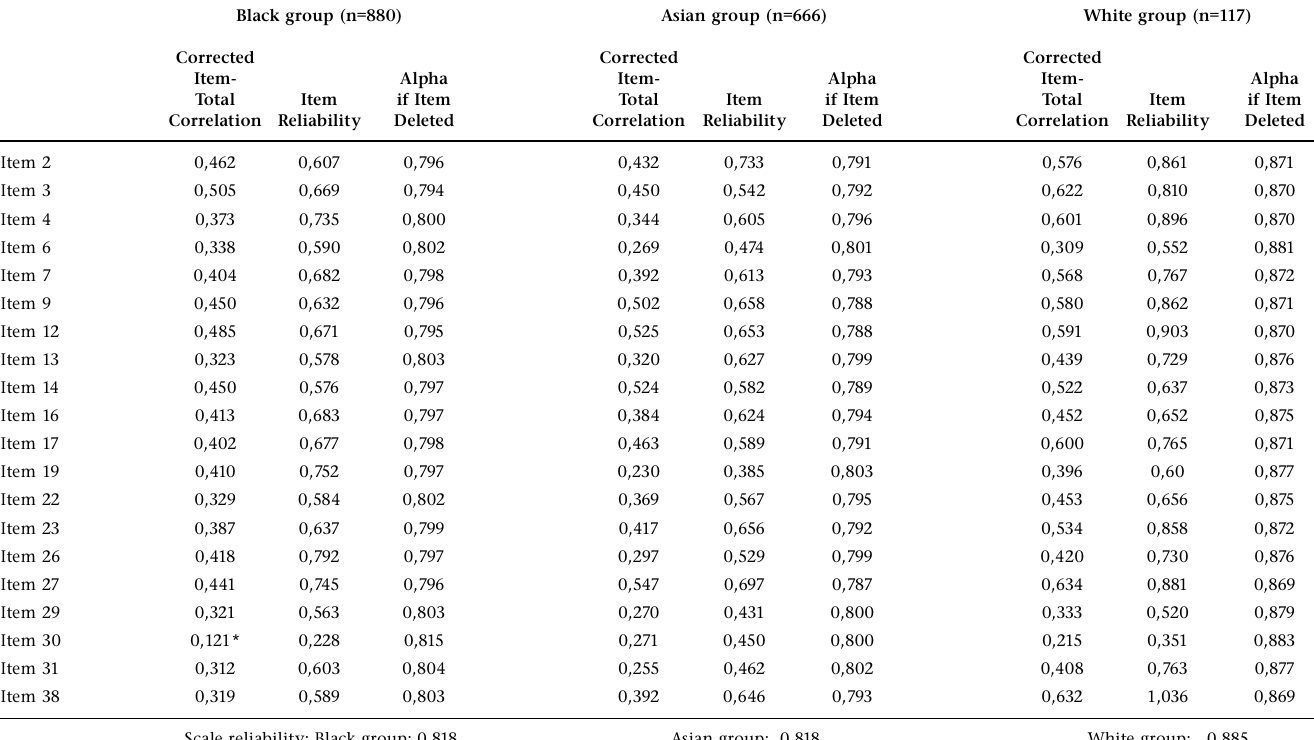
The factor analyses resulted in the extraction of a total of 14 factors for the Black, Asian and White groups. With reference to Figure 1 (Black group), Figure 2 (Asian group) and Figure 3 (White group), two significant factors were identified for the Black, Asian and White groups, based on the results of the scree- test (Cattell, 1966) and Horn’s (1965) criteria. A clear break could be observed in the scree-plot between roots two and three for all the groups. The curve of the eigenvalues of the random dataset (the broken line) intersects the curve of the eigenvalues for the real dataset (the solid line) between roots two and three for each of the groups, indicating two significant factors (Horn,